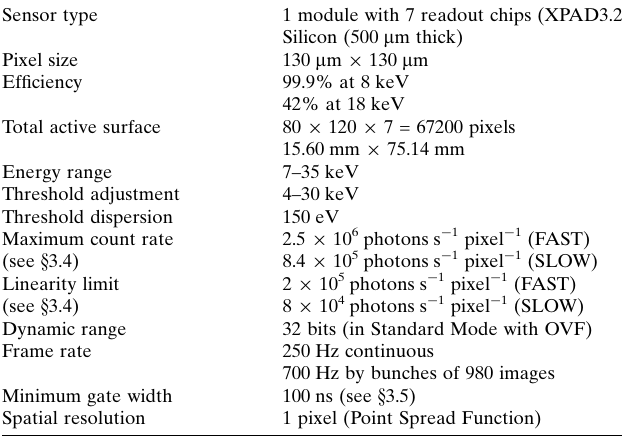
Table 1 Characteristics of the single XPAD-S70 detector module based on the XPAD3.2 readout